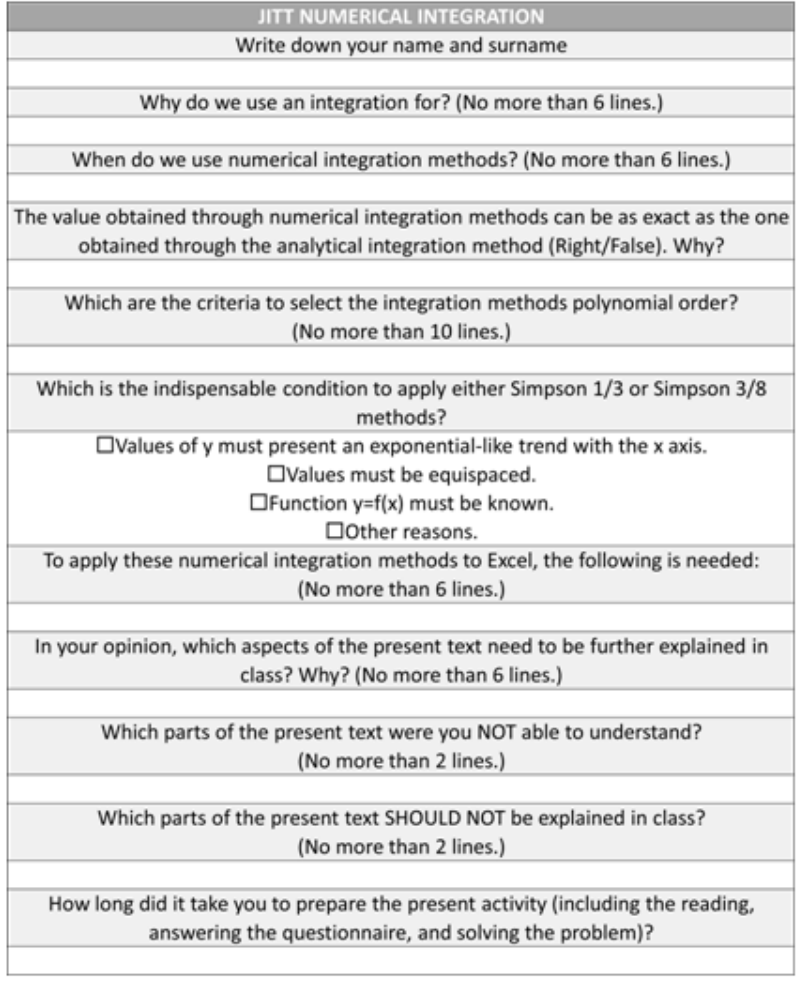
Figure 3. Questionnaire for the numerical integration unit